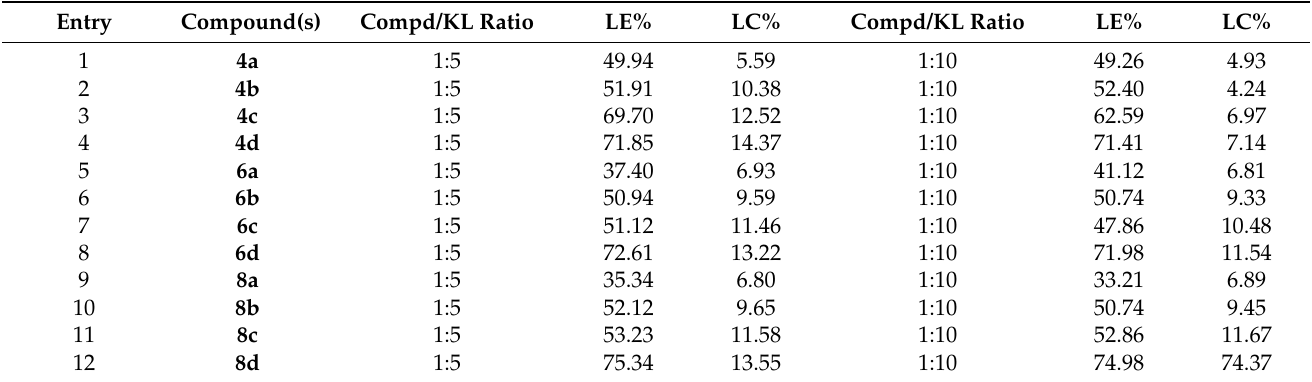
Table 4. Loading capacity and loading efficiency of LNPs in the encapsulation of biomimetic thymine dimers 4a - d and photo-adducts 6a - d and 8a - d a